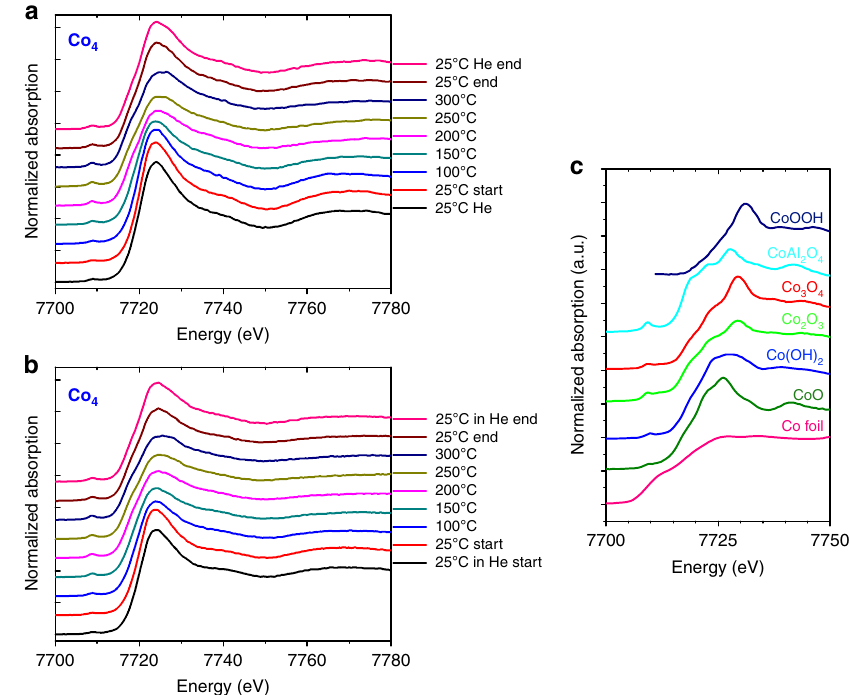
Fig. 4 In situ XANES spectra of Co 4 clusters collected during the applied ramp. a spectra acquired under cyclohexane oxygen 1:10 ratio and b under and 10:1 ratio seeded in He; spectra collected at the indicated temperatures applied from the start (bottom) of the temperature ramp to its end (top). He denotes spectra collected under helium. c XANES spectra of bulk Co standards: Co foil (pink line), CoO (dark green line), Co(OH) 2 (dark blue line), Co 2 O 3 (light green line), Co 3 O 4 (red line), CoAl 2 O 3 (cyan line) and CoOOH (black line). (Spectrum of CoOOH adapted with permission from ref. 54 , CopyRight